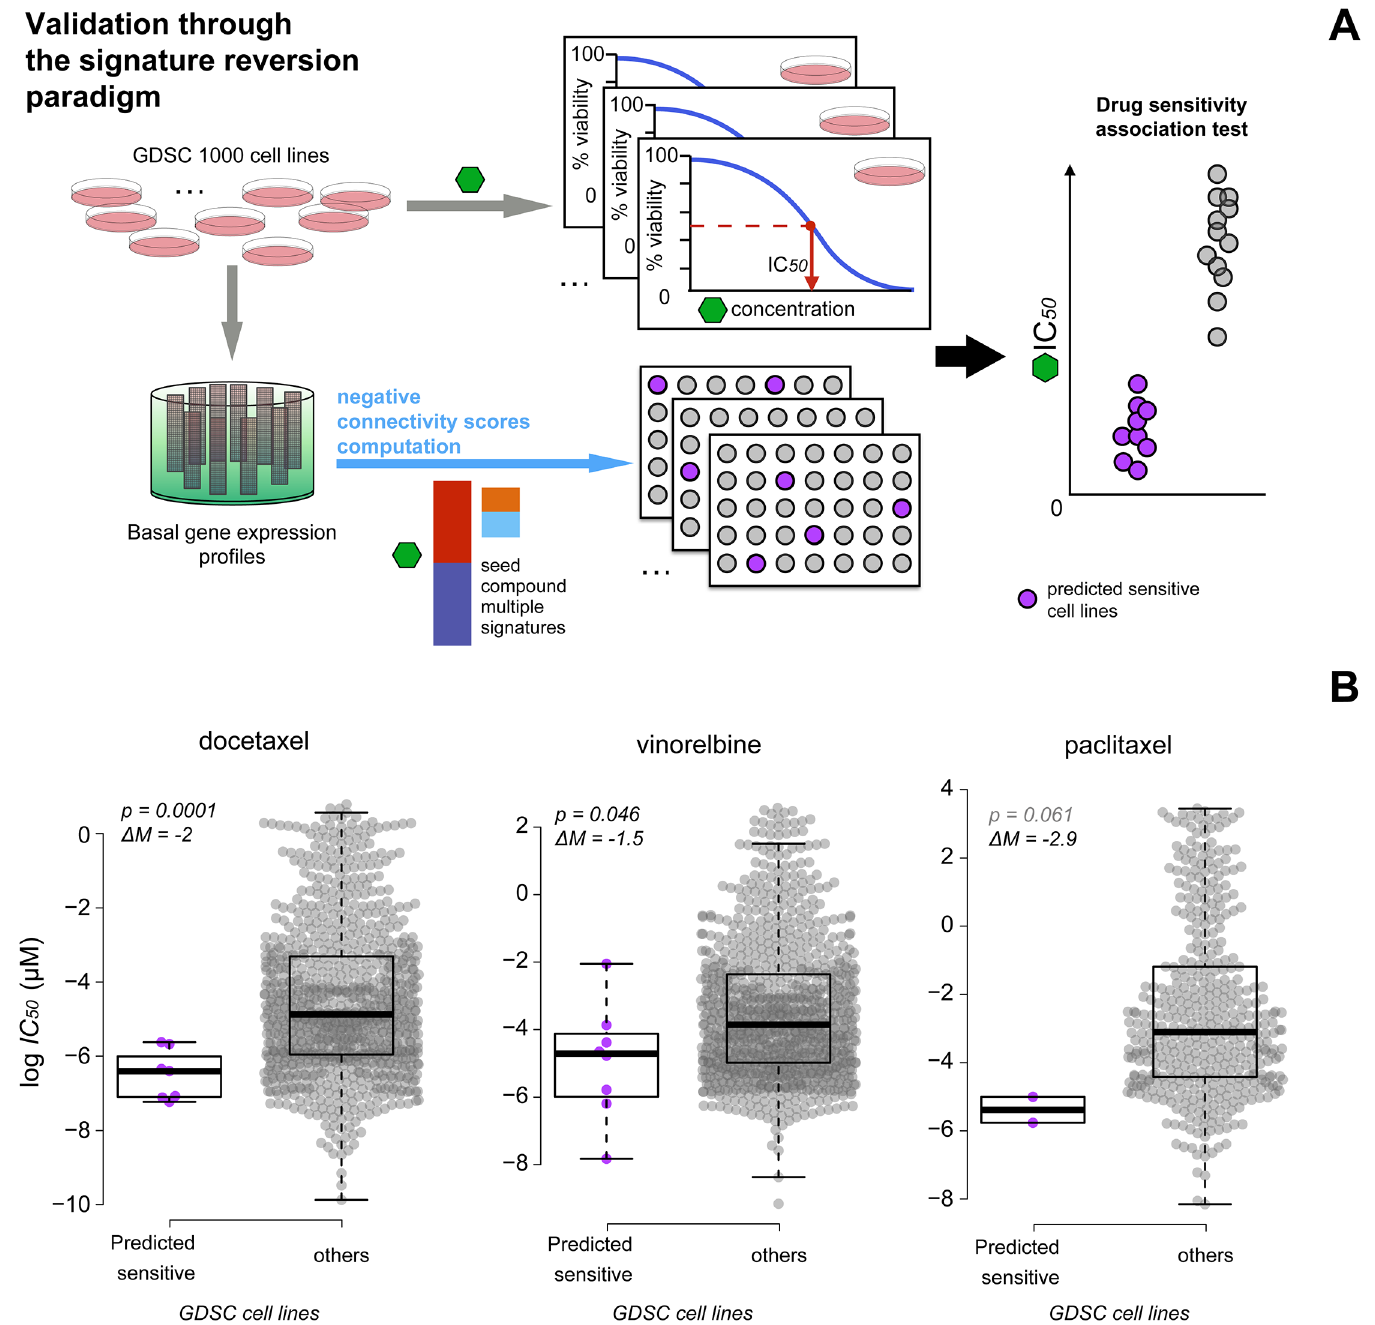
Fig 5. Validation of the predictive ability of the refined signatures. (A) Validation of the signatures through the signature reversion paradigm. The basal expression profiles of the cell lines in the GDSC panel are queried against the refined multiple signatures and connection scores are computed. Cell lines negatively connected to the signatures are predicted to be more sensitive to paclitaxel and its analogue, for which drug response data is available in the GDSC database. (B) Scatter plots showing that the cancer cell lines negatively connected to the Paclitaxel/PIs inconsistent signature and the microtubule stabilising signature (simultaneously) tend to be more sensitive to docetaxel, vinorelbine and paclitaxel. Purple points refer to cell lines significantly negatively connected to the two signatures for which drug response data is available. Gray points refer to the cell lines in the rest of the panel. Coordinates on the y-axis indicate the log IC 50 of the drug under consideration. P-values of an unpaired two sample t-test quantifying the extent of difference in drug response across the two groups of cell lines are reported in the insets together with the difference between the two log IC 50 means ( Δ M).